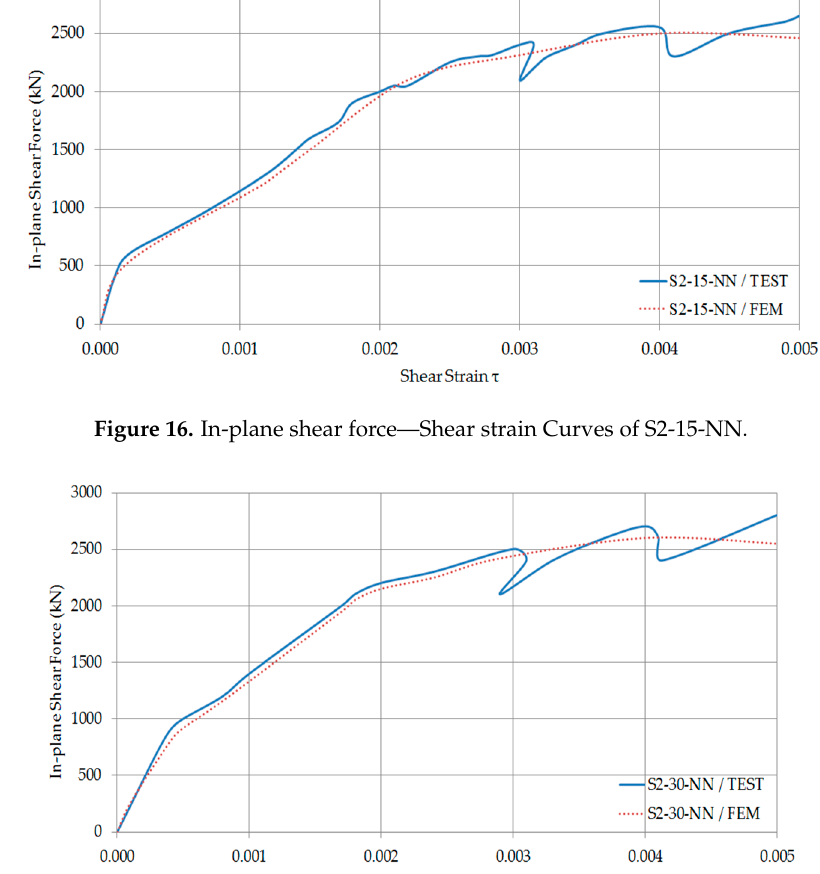
Table 2. Experimental versus numerical modelling results.